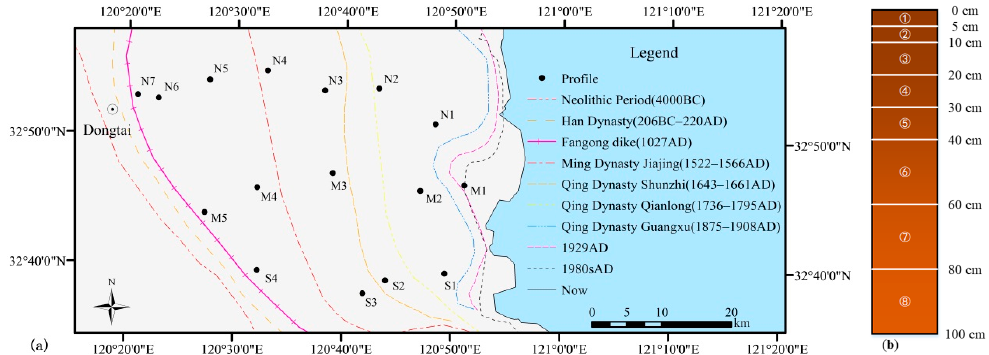
Figure 2. Locations of soil profiles and sampling depth in a profile: ( a ) sixteen sampling sites, which,